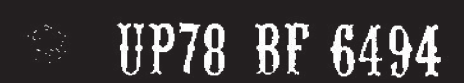
Figure 18: Detected number plate obtained after clearing the noise of the background.